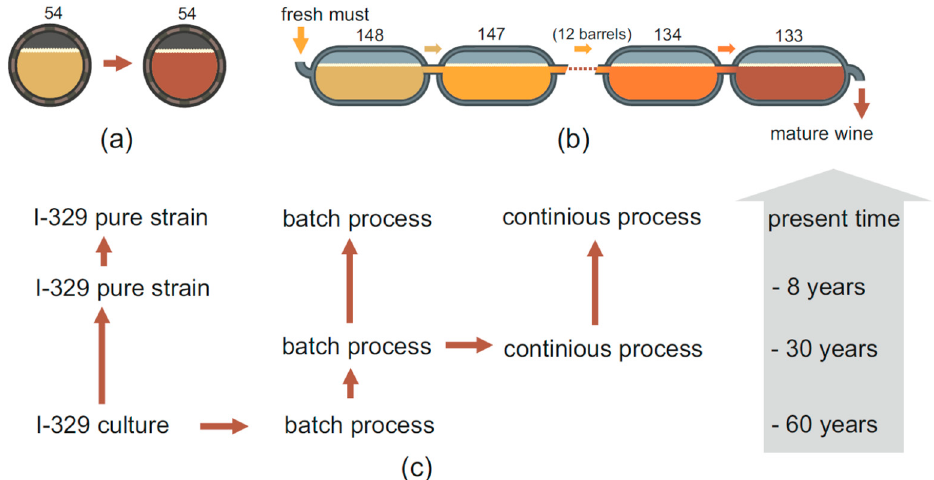
Figure 1. Schemes of batch ( a ) and continuous ( b ) processes used by the Oreanda winery for the production of sherry-like wine. Note that continuous process involves 16 barrels. A diagram showing the sources of velums used in these winemaking processes and a timescale is shown in ( c ). The second process, similar to the criaderas–solera system, was launched in 1992, and is carried out continuously in a set of 16 connected 5000 L metal barrels 60% filled (Figure